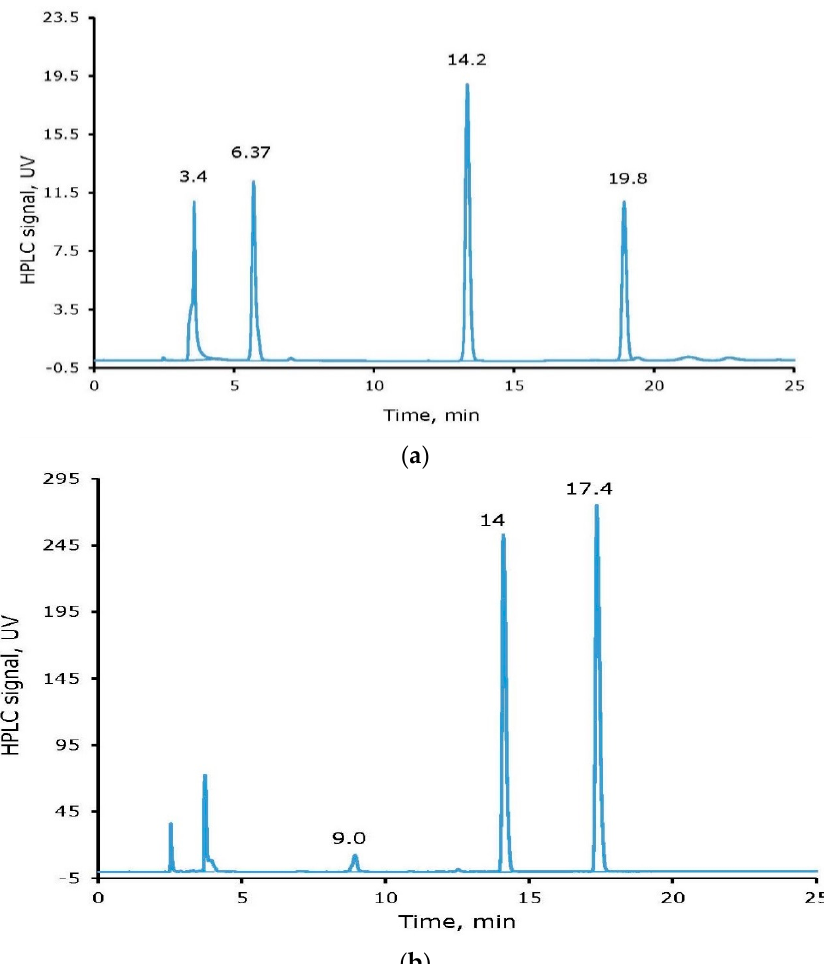
Figure 2. HPLC chromatograms of the reaction mixtures of non-radioactive iodine labeling of tyrosine ( a ) and cyclo Arg- Gly-Asp-d-Tyr-Lys (cRGDyK) ( b